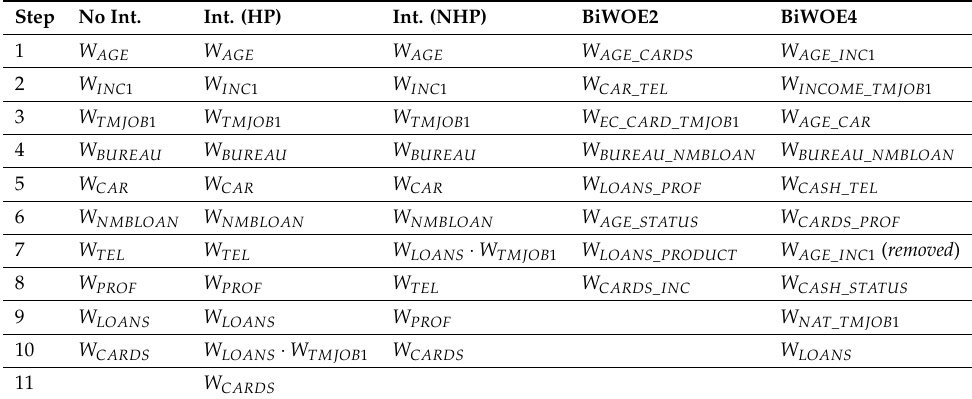
Table A2. Summary of the stepwise variable selection processes carried out for each method on the CS_ACCEPTS